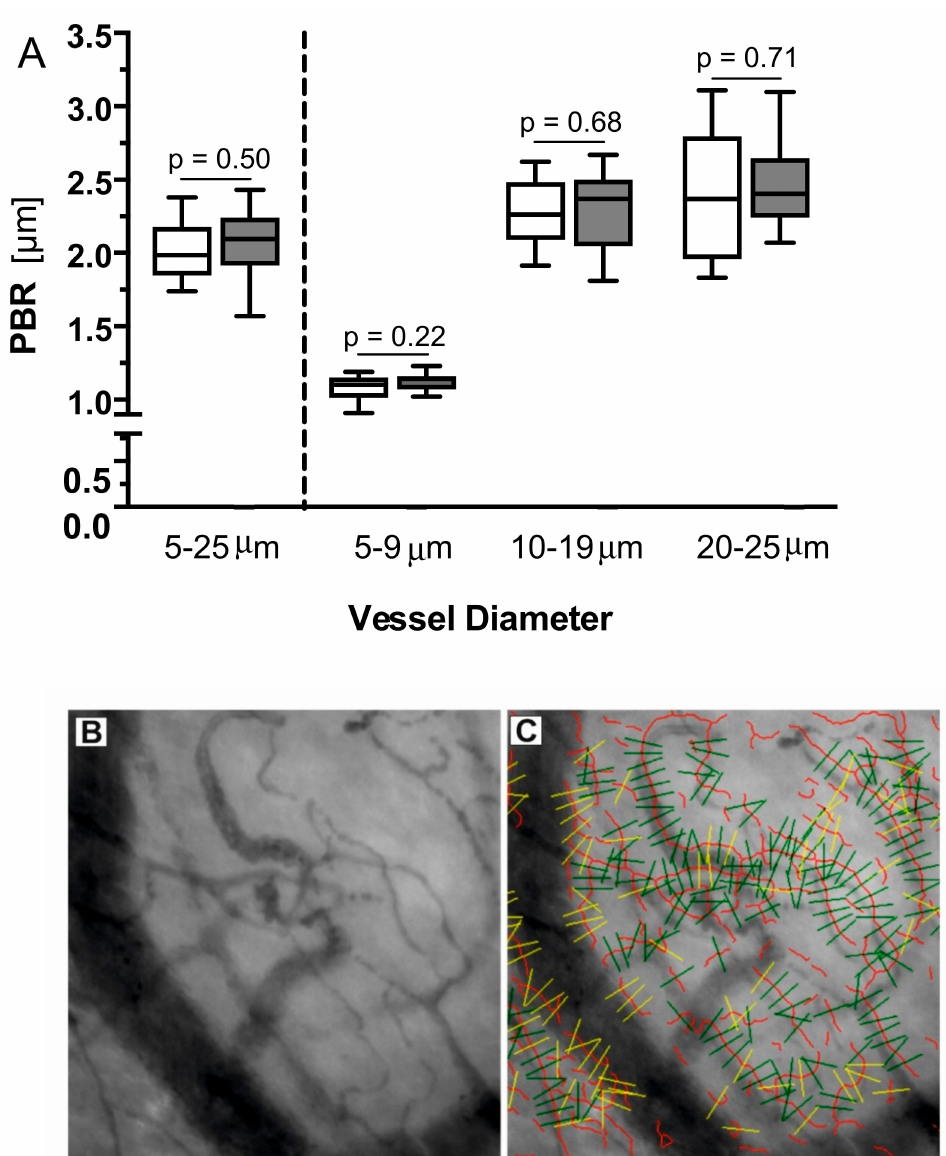
Figure 2. ( A ): Boxplots of PBR values of patients with a high C / D ratio (white) and low C / D ratio (grey) based on the di ff erent microvascular diameter ranges. No di ff erence was detected between the groups. ( B ): Representative image of the sublingual mucosa acquired with the SDF camera in a kidney transplant patient. ( C ): Exemplary picture of a video recording showing the automatic identification of all available micro-vessels with a diameter between 5 to 25 µ m. Vascular segments are marked every 10 µ m along the assessed microvasculature (red lines) by the GlycoCheck software (green lines: valid segments for further analysis, yellow lines: discarded by quality